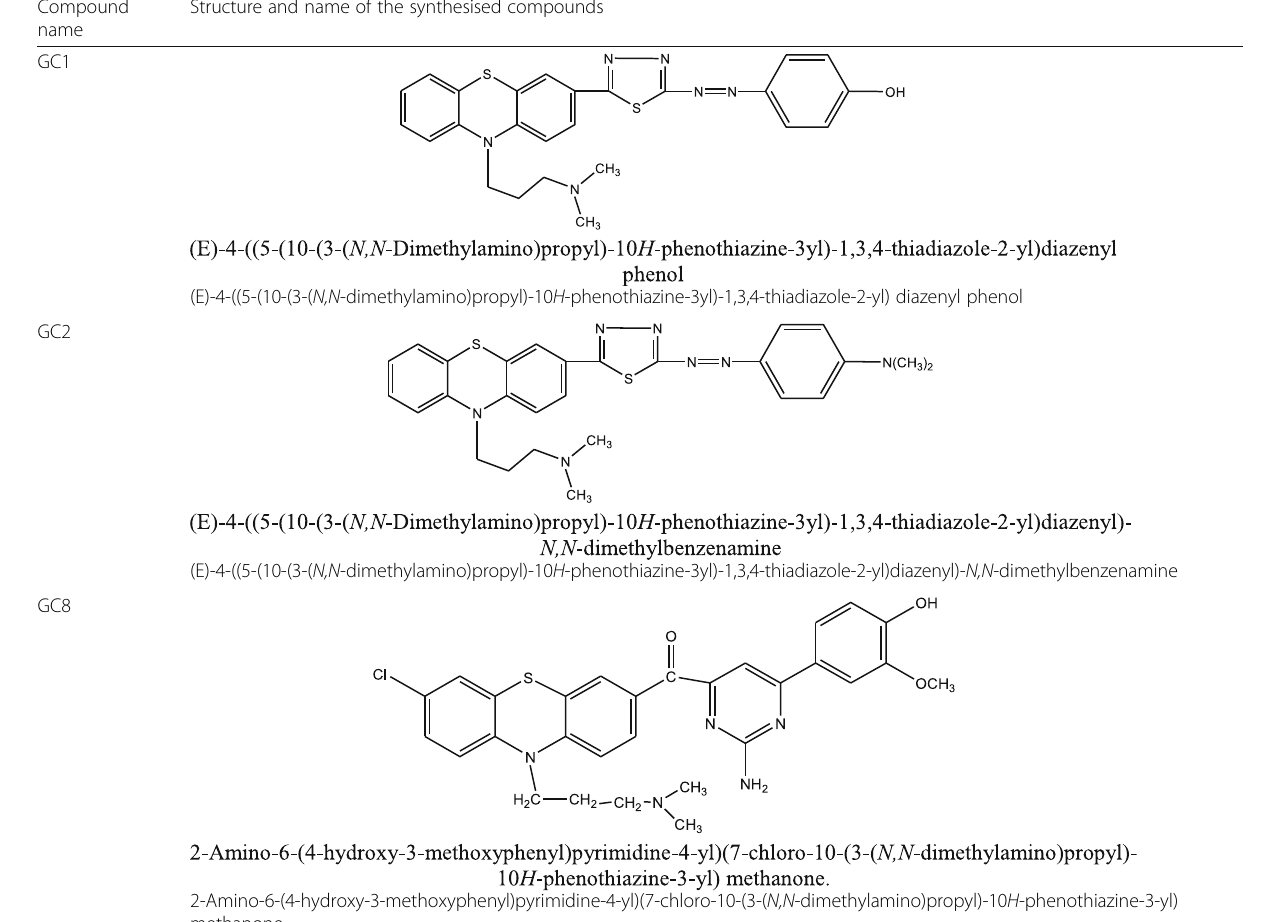
Table 1 Structure and name of the synthesised compounds Compound Structure and name of the synthesised name